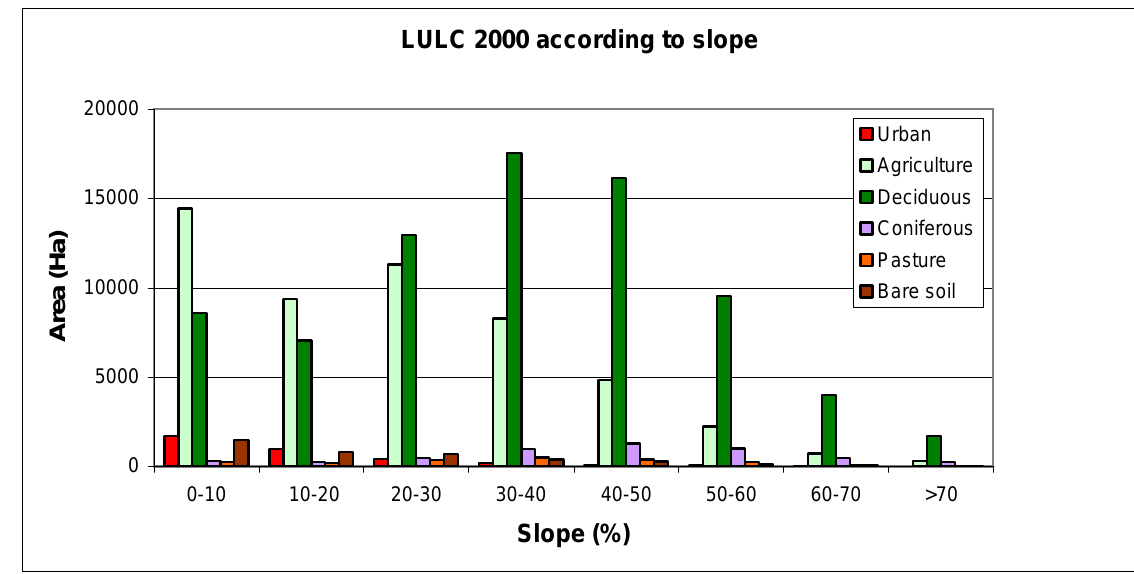
Figure 8. Land use\land cover and Slope in 2000 LULC 2000 according to